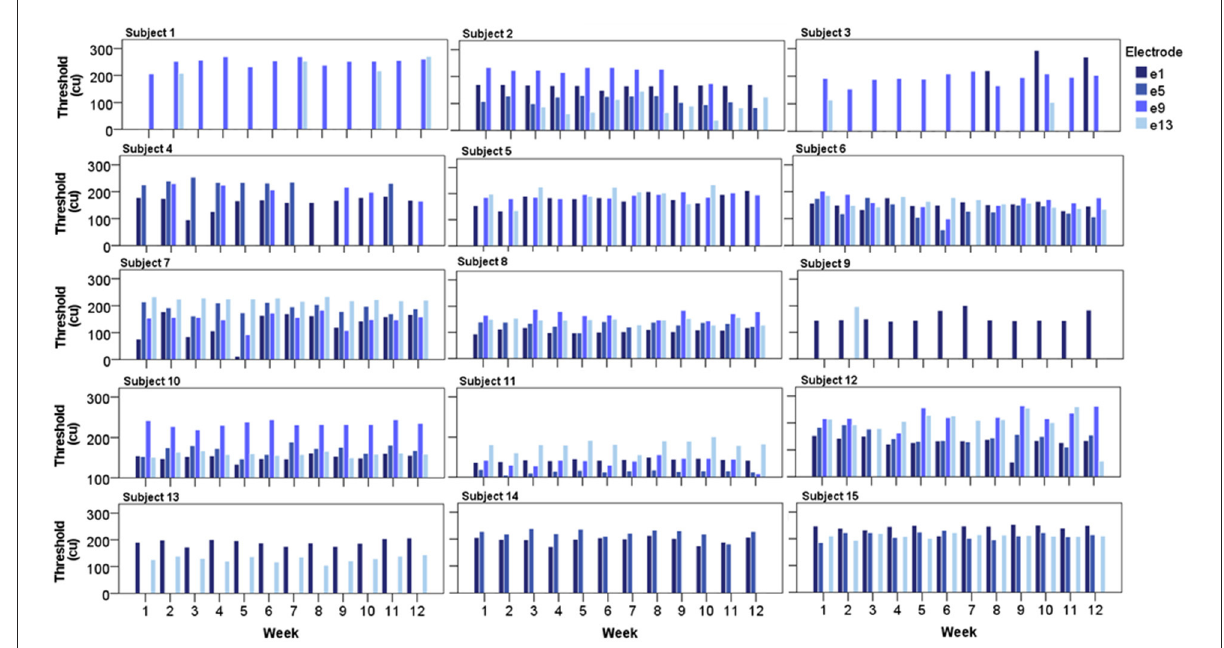
FIGURE5 Bar charts displaying each subject’s eCAP threshold from all four recording electrodes over the 12-week testing period ( N = 15).